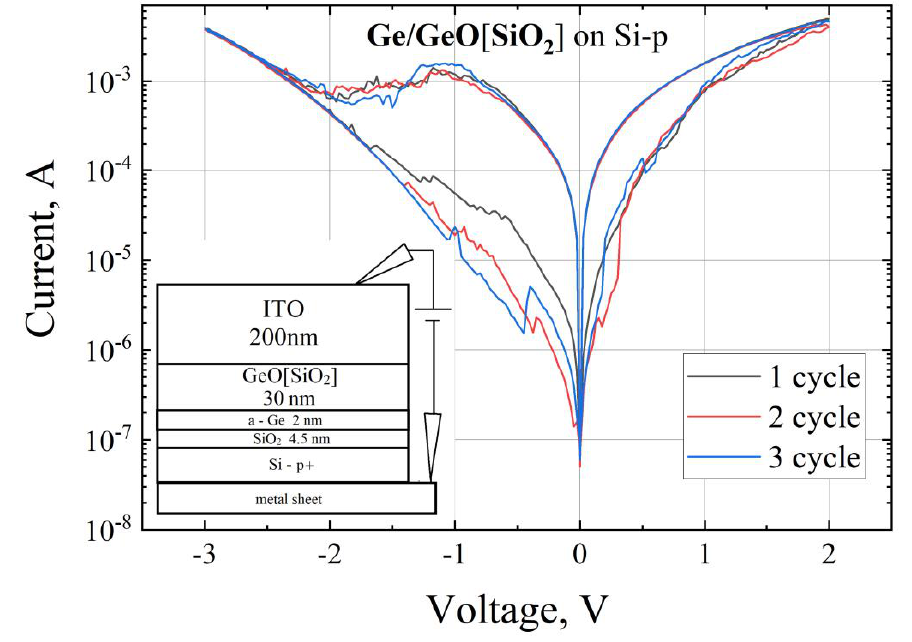
Figure 10. I – V curves of sample D. Figure 10. I–V curves of sample